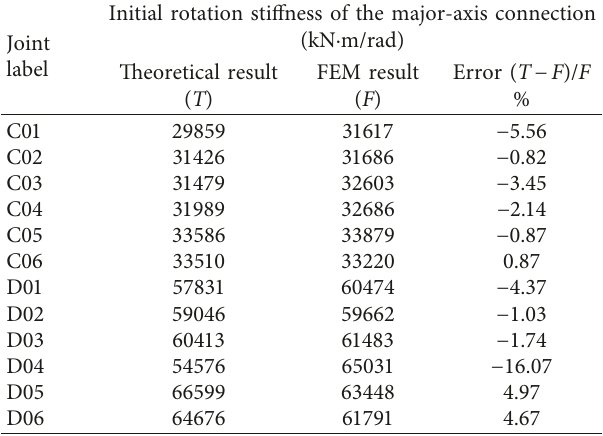
Table 12: Comparison results between the theoretical and FEM analysis. Initial rotation stiffness of the major-axis connection Joint label Theoretical